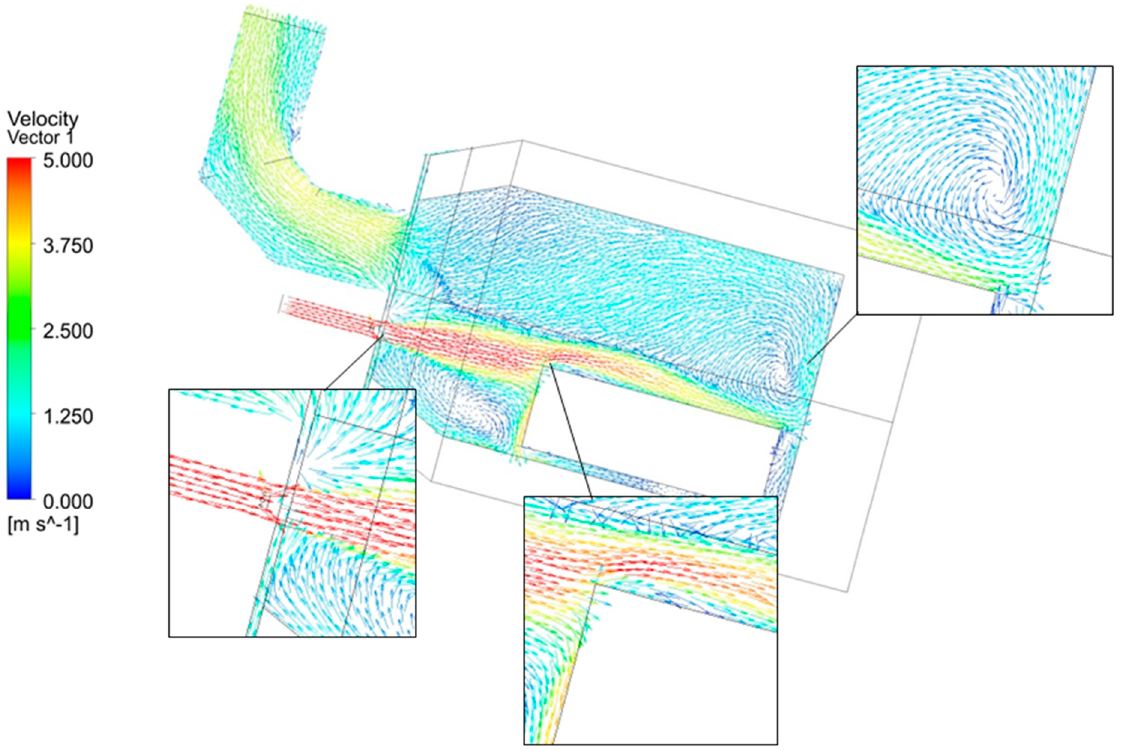
Figure 16. Model results: Vector of velocity with OEC technology + modification of burner. The data presented in Figure 17 verify the CFD simulation model as its results are compara- ble with those from experimental measurement. Values used to construct this figure are listed in Appendix C. Thus, the method used for simulation model creation in Ansys can be considered as correct. The results obtained are relevant and can be used to predict the distribution of tempera- ture in the combustion chamber and also the formation of emission components depending on the type of burner. Figure 17. Verification of CFD model. ( a ) NO mass concentration; ( b ) CO mass concentration. Table 5 presents an overview of the emissions produced per melting cycle of charge material. The charge material was aluminum ingots. The time required to remelt the charge material was defined by the condition that the average temperature of the charge was 750 °C. The CO 2 , CO, and NO values shown in Table 5 were calculated based on Equation (2) from the results of the experi- mental measurements and fuel consumption presented in Table 2.